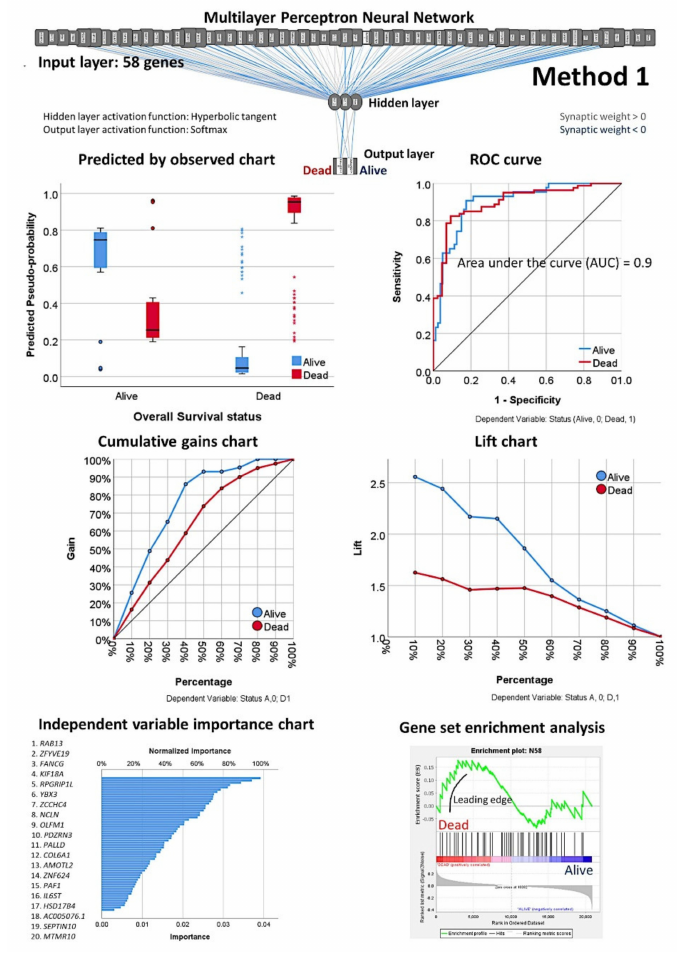
Figure 6. Multilayer perceptron analysis using the selected 58 genes (Method 1 continuation). As shown in Figure 4, the neural networks reduced the initial input of 20,862 genes to 58 predictive genes. Next, the overall survival outcome (dead/alive) was predicted using 58 genes and a neural network. Several parameters display the network performance: model summary; classification results; receiver operating characteristic ROC curve; cumulative gains chart; lift chart; predicted by observed chart; and the independent variable importance analysis. ROC analysis displays a curve for each categorical dependent variable and category and the area under each curve [34–36,44,45,55,56]. The genes were ranked according to their normalized importance for predicting the overall survival outcome as a dichotomic variables (dead vs. alive). A GSEA analysis confirmed the association toward a dead outcome. The characteristics of the network were as follows. Case processing: training n = 93 (76%); testing n = 30 (24%). Units n = 58. Rescaling = standardized. Hidden layer: number = 1; units = 2; activation function = hyperbolic tangent. Output layer: dependent variables = 1 (overall survival outcome dead/alive); units = 2, activation function = softmax, error function = cross-entropy. Model summary: training, cross-entropy error = 30.8, 14% of incorrect predictions; testing, cross-entropy error = 14.5, 23% of incorrect predictions. Classification: training, 86% overall correct (93.8% alive, 82% dead); testing, 77% overall correct (82% alive, 74% dead). Area under the curve = 0.9. Top 10 most relevant genes were RAB13 , ZFYVE19 , FANCG , KIF18A , RPGRIP1L , YBX3 , ZCCHC4 , NCLN , OLFM1 , and PDZRN3 . A complete description of the multilayer perceptron is present in our recent publication (Carreras J. et al. Artificial Neural Networks Predicted the Overall Survival and Molecular Subtypes of Diffuse Large B-Cell Lymphoma Using a Pan-cancer Immune-Oncology Panel. Cancers 2021 , 13 , 6384; https://doi.org/10.3390/cancers13246384)